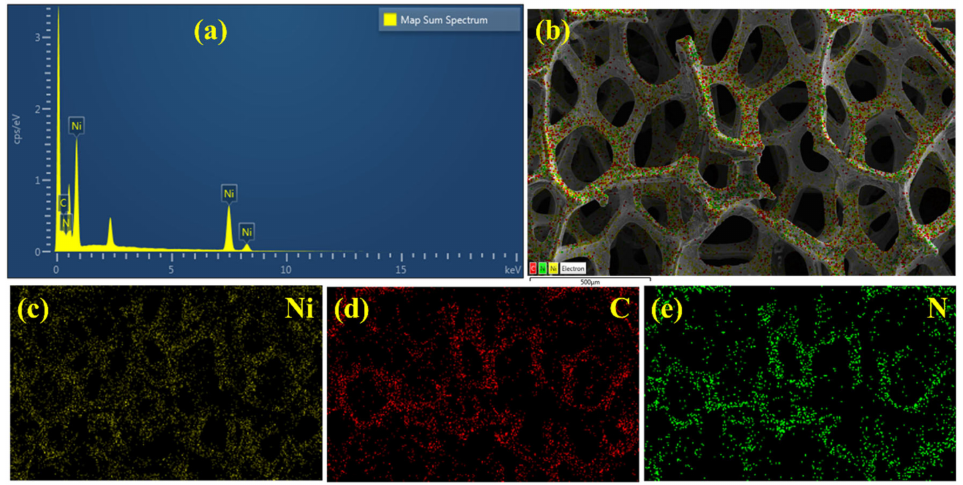
Figure 3. ( a ) EDAX spectrum, ( b ) FESEM micrograph used for EDAX analysis of PANI/NF and the corresponding elemental mappings of ( c ) Ni, ( d ) C, and ( e )